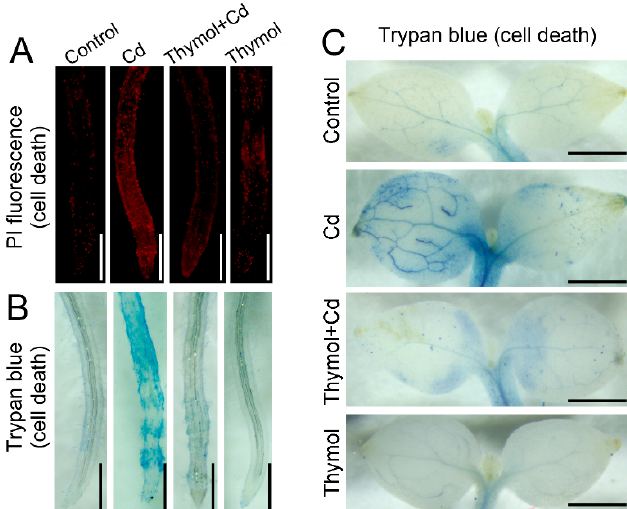
Figure 5. The effect of thymol on cell death in tobacco seedlings under Cd stress. The roots of seedlings were treated with water (control), CdCl 2 (20 μ M), CdCl 2 (20 μ M) + thymol (100 μ M), and thymol (100 μ M) for 72 h. ( A ) The roots were loaded with PI and photographed with a fluorescent microscope; ( B ) The roots were stained with trypan blue and photographed with a stereoscopic microscope; ( C ) The seedlings were excised at the base of the stem and supplied trypan blue for 6 h through the cut stems. Then the leaves were decolorized with ethanol and photographed with a stereoscopic microscope. Bar = 1 mm.